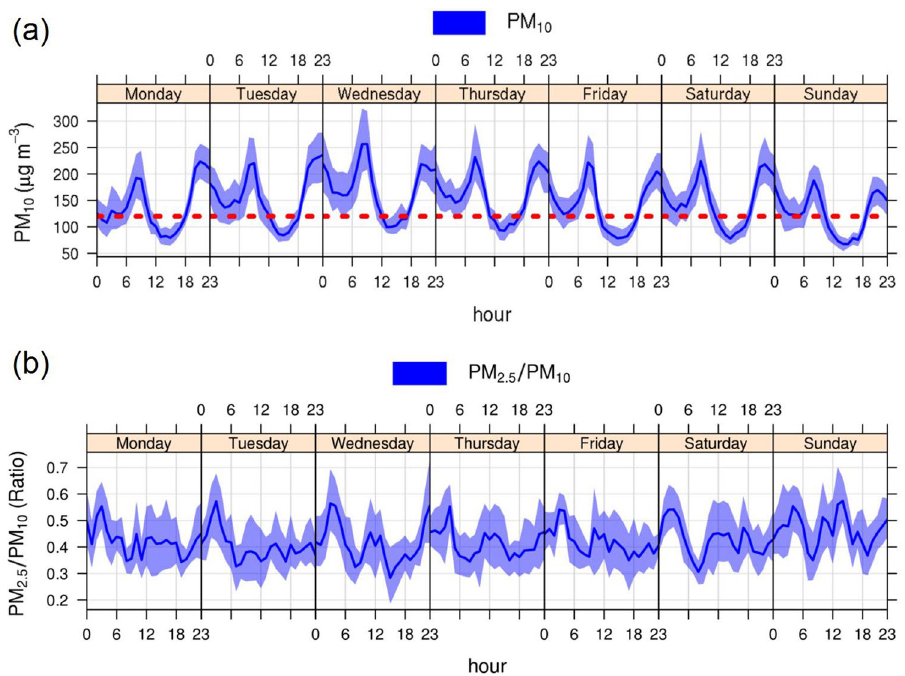
Figure 5. Variation of four year averages of ( a ) PM 10 concentrations and ( b ) PM 2.5 /PM 10 ratio on a daily basis in the selected winter months (November to